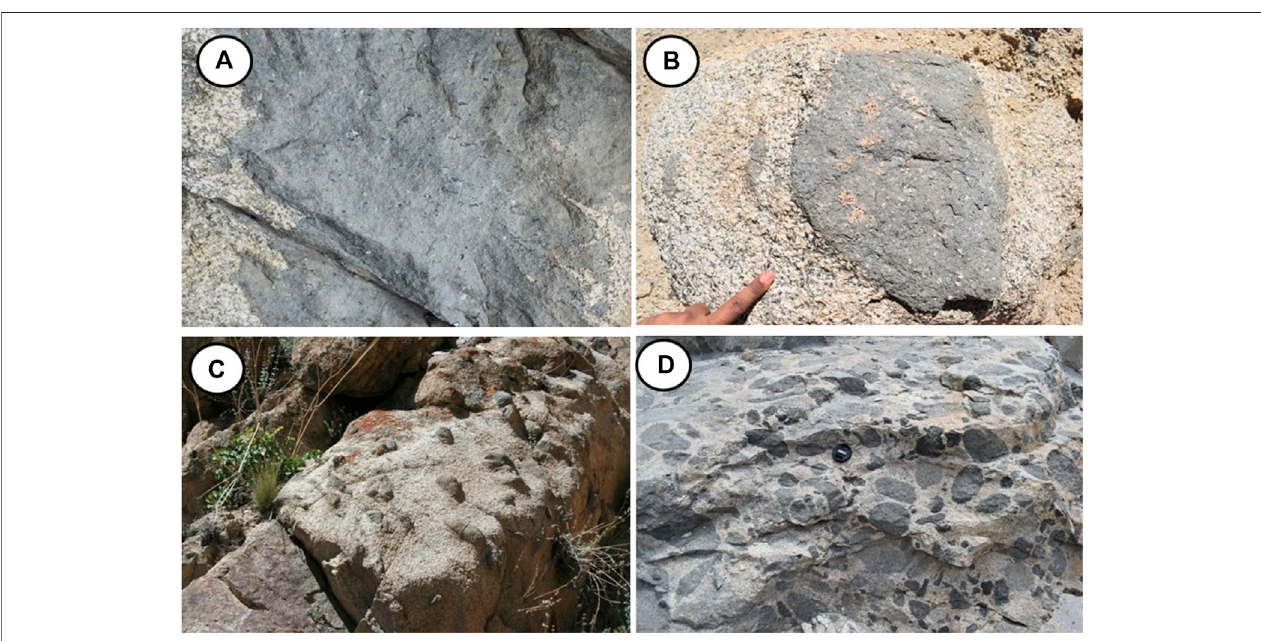
FIGURE 3 | (A) Fine grained ma fi c body contains frequent quartz (glass) xenocrysts and shows serrated contacts with host granite. (B) A large enclave containing ma fi c-felsic phenocrysts showing sharp contact with host granite. Partial diffuse contact can also be noted. (C) Elongated ma fi c enclave swarms follow a particular direction in the host granite. Note the enclaves form monadnock ridge. (D) Randomly oriented closely spaced holomelanocratic, melanocratic to mesocratic enclaves with variable shapes and sizes are hosted in granite from northern margin of Ladakh Batholith.